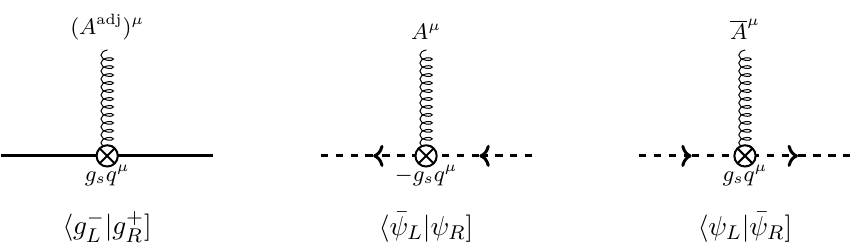
| g + ] , h ¯ ψ L | ψ R ] and h ψ L | ¯ ψ R ] , the L R